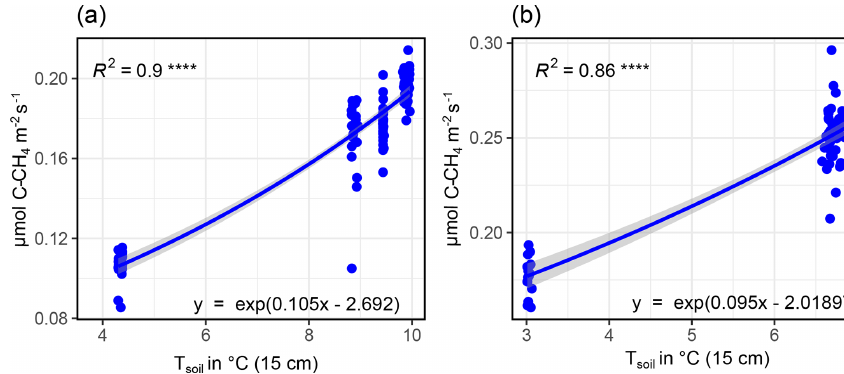
Figure B3. Exponential regressions between CH 4 fluxes and T S, 15cm for UGR-1 (a) and UGR-2 (b) .